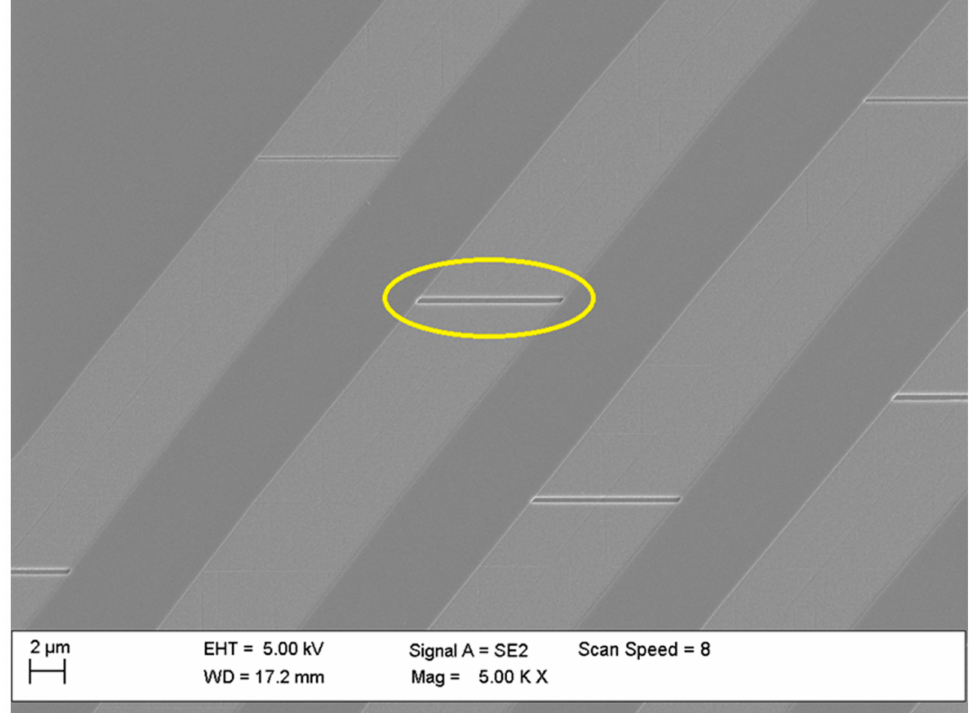
Figure 9. Etched waveguides with marked places of too low an exposure dose during electron beam lithography process.